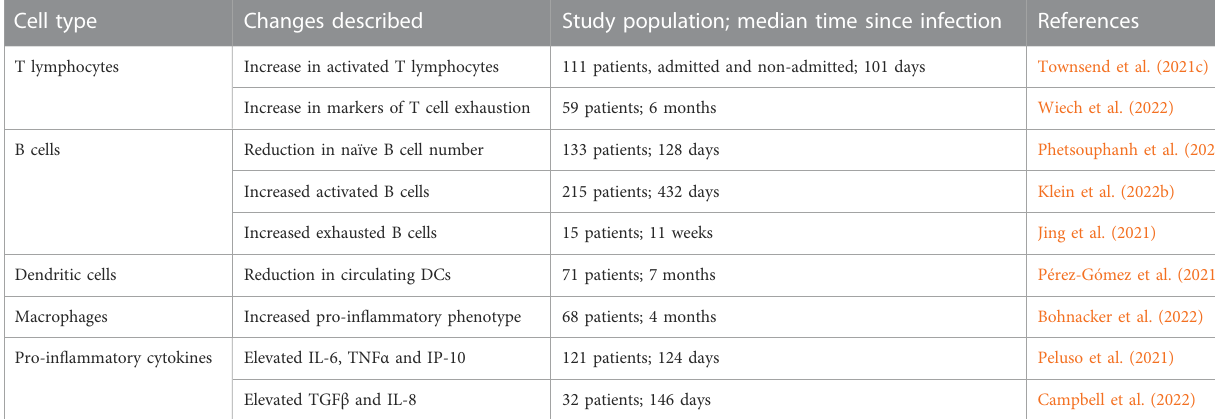
TABLE 3 Immune cell and cytokine changes following SARS-CoV-2